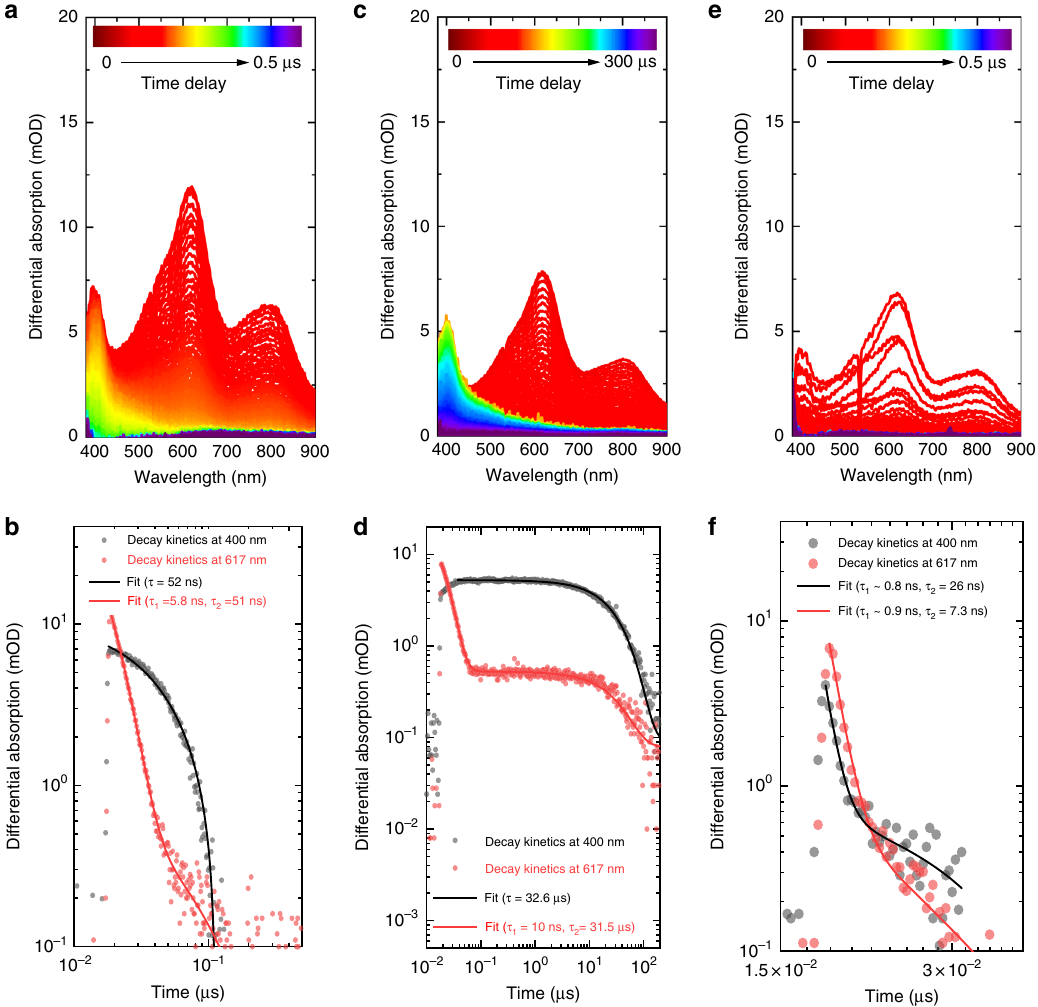
Fig. 3 Transient absorption spectra and decay kinetics. Decay kinetics were probed at 400 (black dots) and 617 nm (red dots), showing mCP in a , b ambient; c , d deoxygenated atmosphere, and mCP-COT in e , f deoxygenated atmosphere,